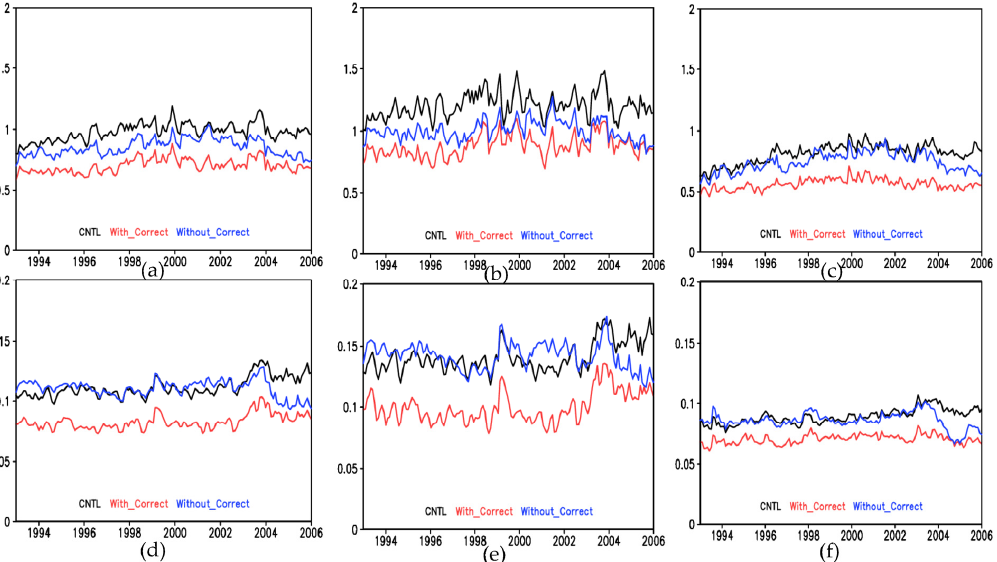
Figure 10. Time series of the RMSEs of HC300–700 ( a – c ) and SC300–700 ( d – f ) relative to EN4.2.2 in different ocean basins from different experiments. ( a , d ) Southern Indian and Southern Pacific oceans, ( b , e ) Southern Indian Ocean, ( c , f ) Southern Pacific Ocean.